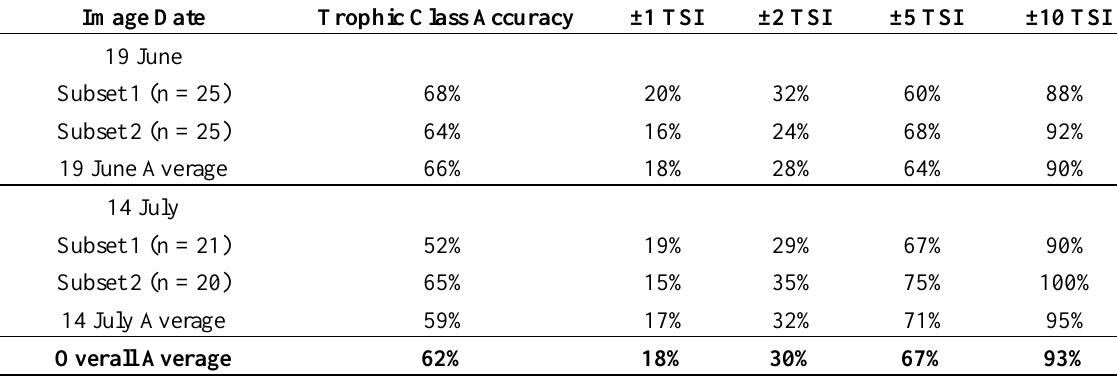
, reported as percent trophic (SDT) (SDT)